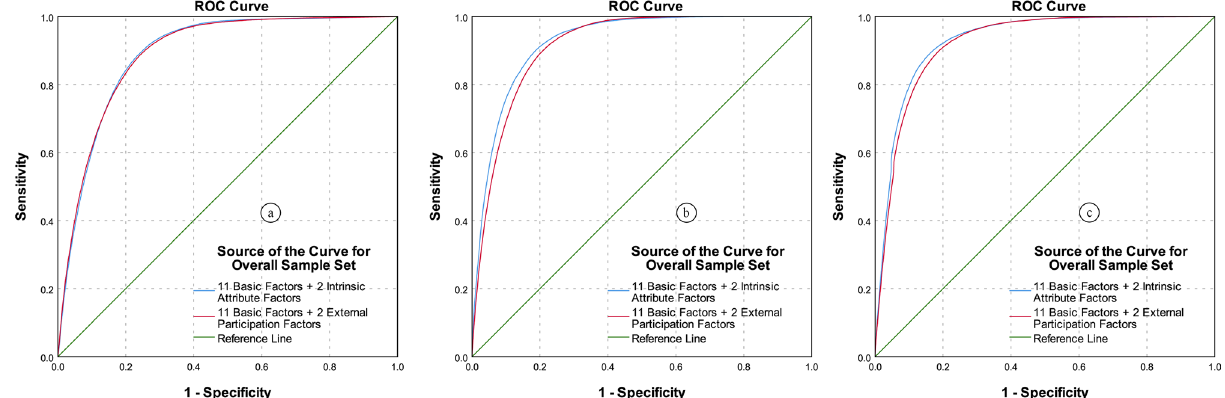
Figure 17. The ROC curves analysis for intrinsic attribute factors and external participation factors by ( a ) LR model, ( b ) ANN model, and ( c ) SVM model.